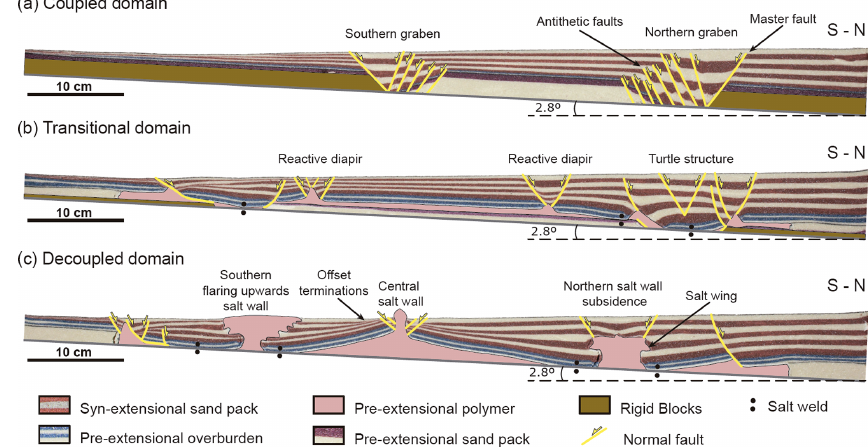
Figure 5. Cross-sections at the end of the extensional deformation (127mm) across the different structural domains of model 1. (a) Coupled domain; (b) transitional domain; (c) decoupled domain. See Fig. 4d for location. Before the sedimentation of each syn-extensional layer, the rig was tilted 0.35 ◦ northwards to simulate the progressive tilting of an extensional rifted margin, reaching a regional dip of 2.8 ◦ at the end of the extensional